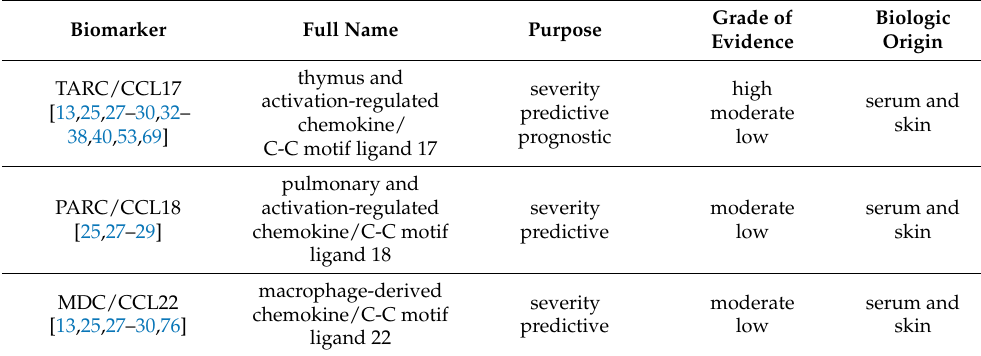
Table 1. Candidate biomarkers in atopic